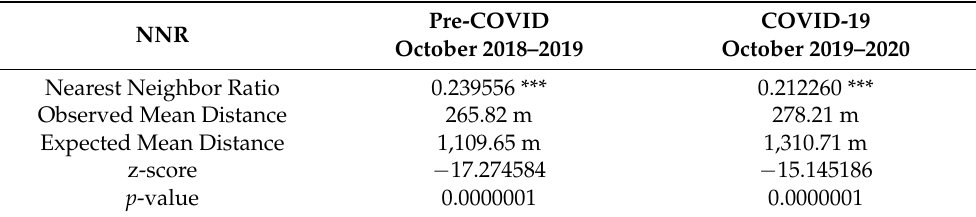
Table 3. Nearest neighbor